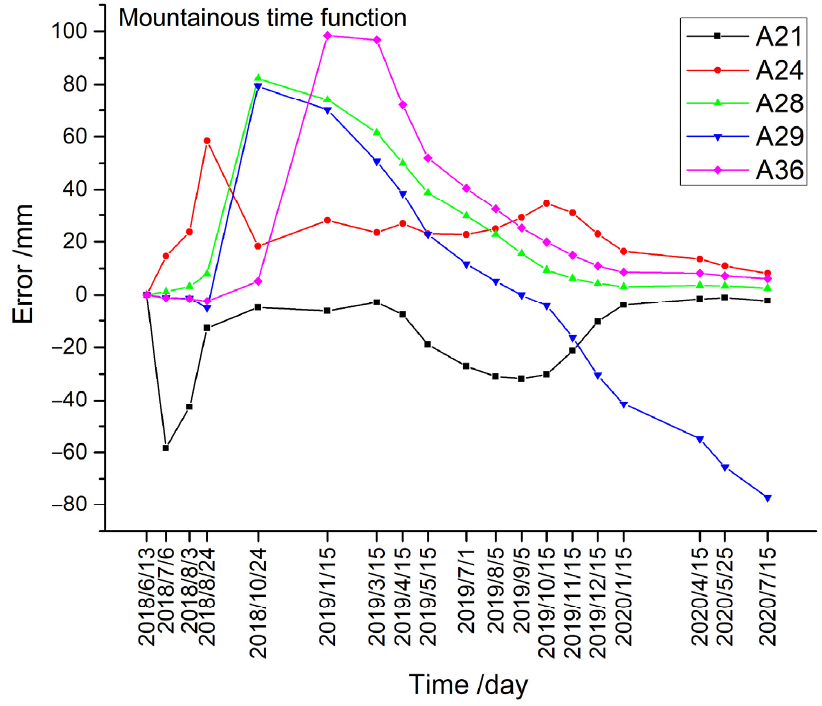
Figure 10. Error curves of the typical points using the mountainous time function method.